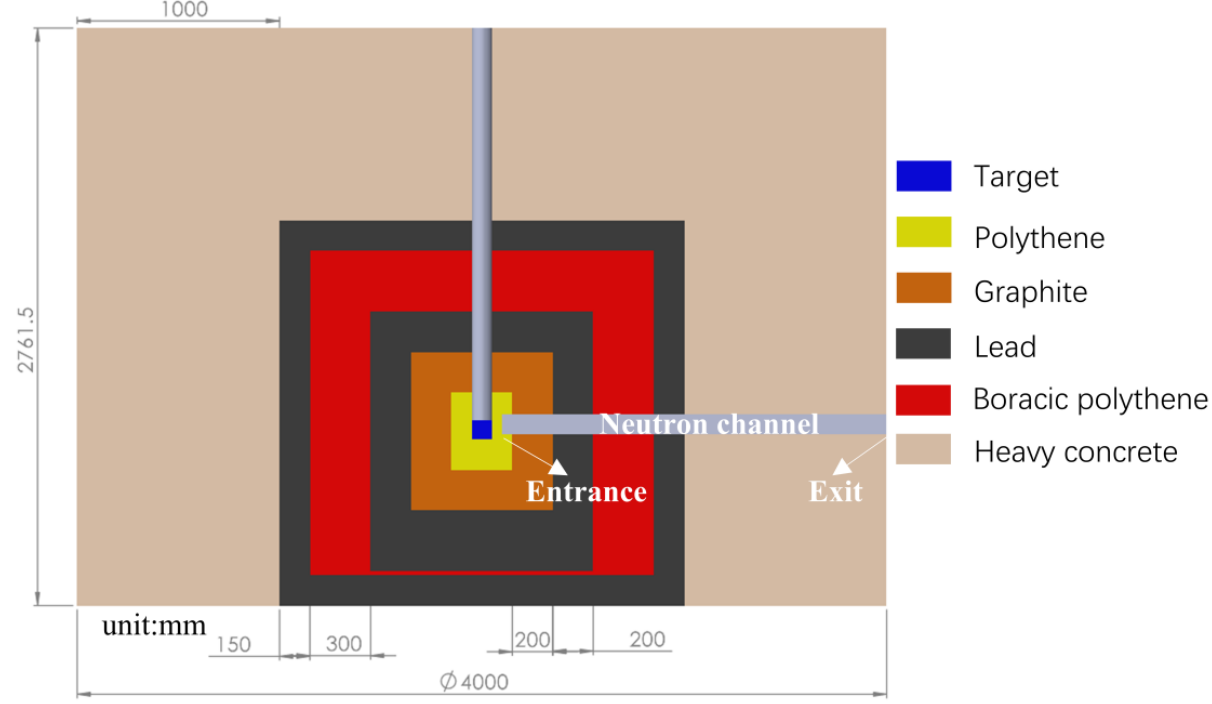
Figure 6. The geometrical arrangement of the multilayer structure TMR.